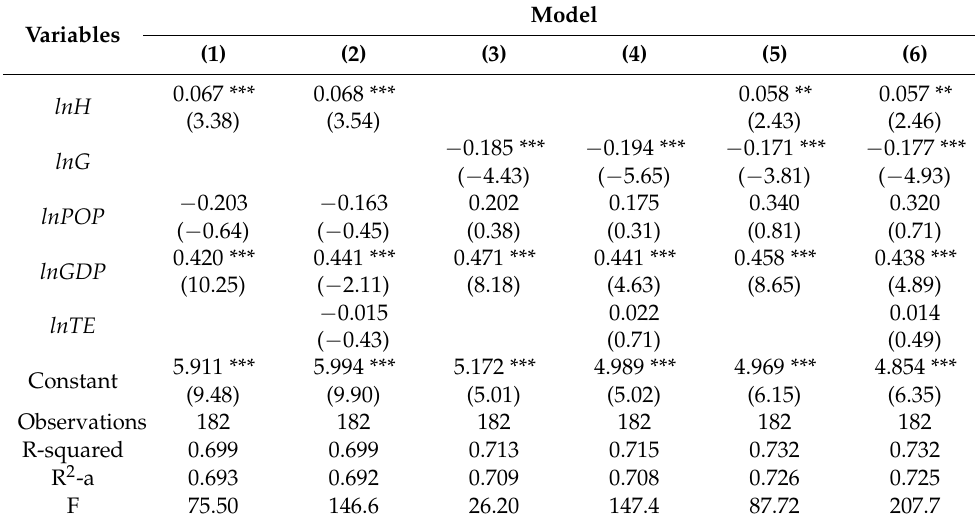
Table 5. Regression results